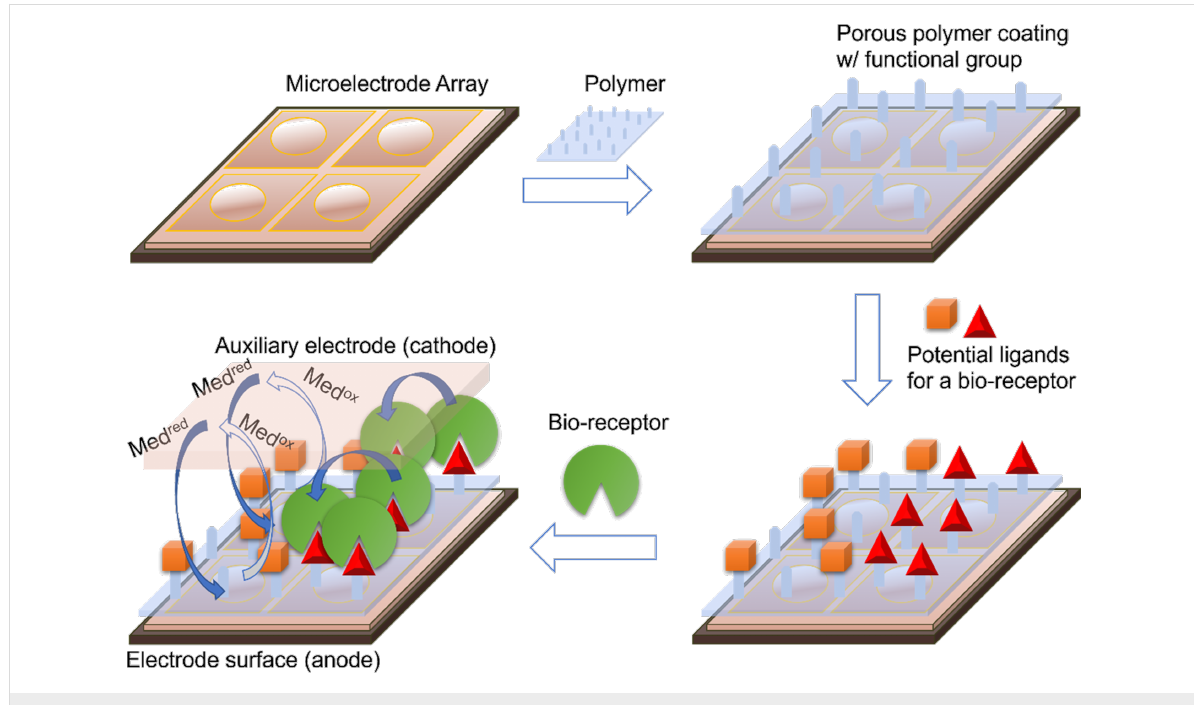
Figure 3: An indirect method for detecting binding events.